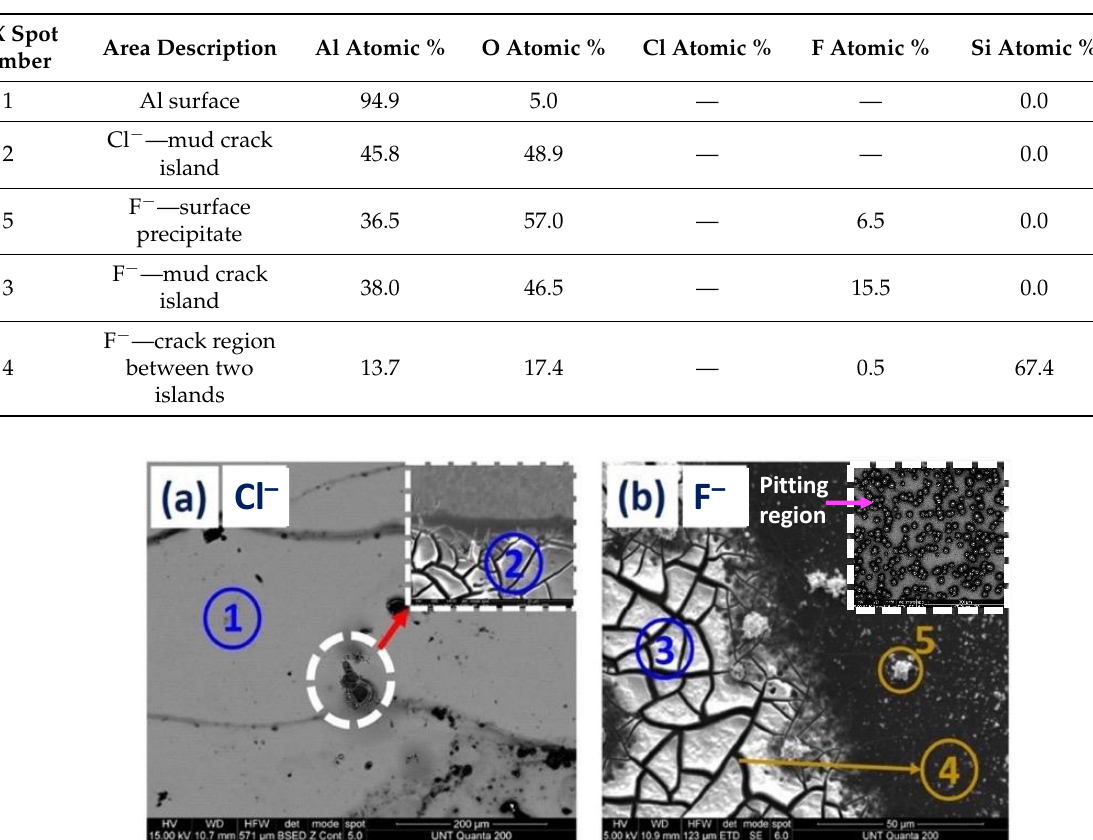
Figure 3. SEM analysis of corroded Al surface. ( a ) Al surface after 24 h immersion in 5 ppm Cl − at pH 5. Inset (white dotted line): Close-in view of mud crack in Cl − -induced corrosion. ( b ) Al surface after 24 h immersion in 5 ppm F − at pH 5 — close-in view of mud cracks formed in F − -induced corrosion. Inset (white dotted line): Close-in view of the pitting region. Note: EDX analyzed the numbered cycle areas; results are listed in Table 1.